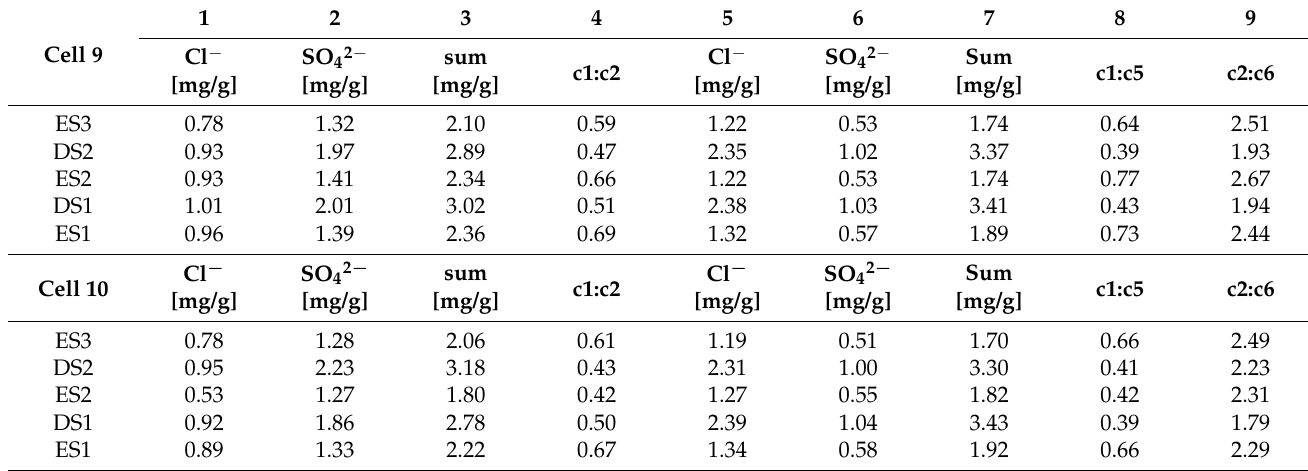
Table 9. Anion concentration in DS and ES after